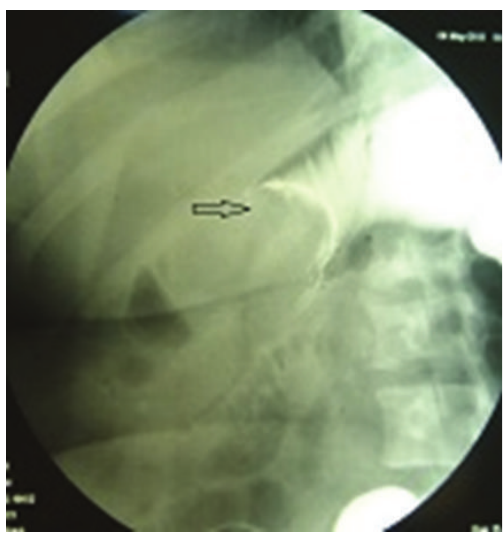
Figure 1: Double-contrast barium enema examination showing an ovoid filling defect (arrow) in the cecum and ascending colon.